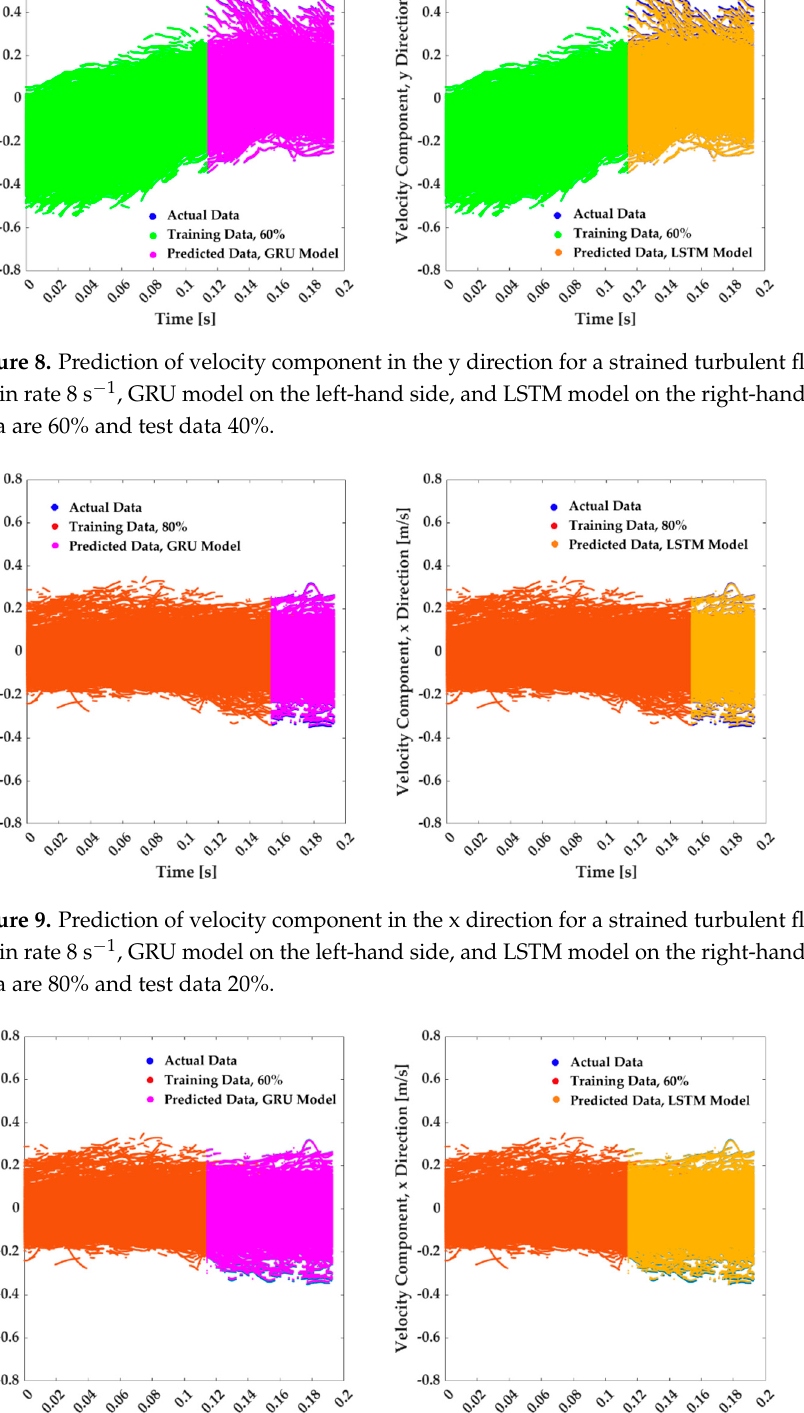
Figure 10. Prediction of velocity component in the x direction for a strained turbulent flow with mean strain rate 8 s − 1 , GRU model on the left ‐ hand side, and LSTM model on the right hand side. strain rate 8 s − 1 , GRU model on the left-hand side, and LSTM model on the right hand side. Training Training data are 60% and test data 40%. data are 60% and test data